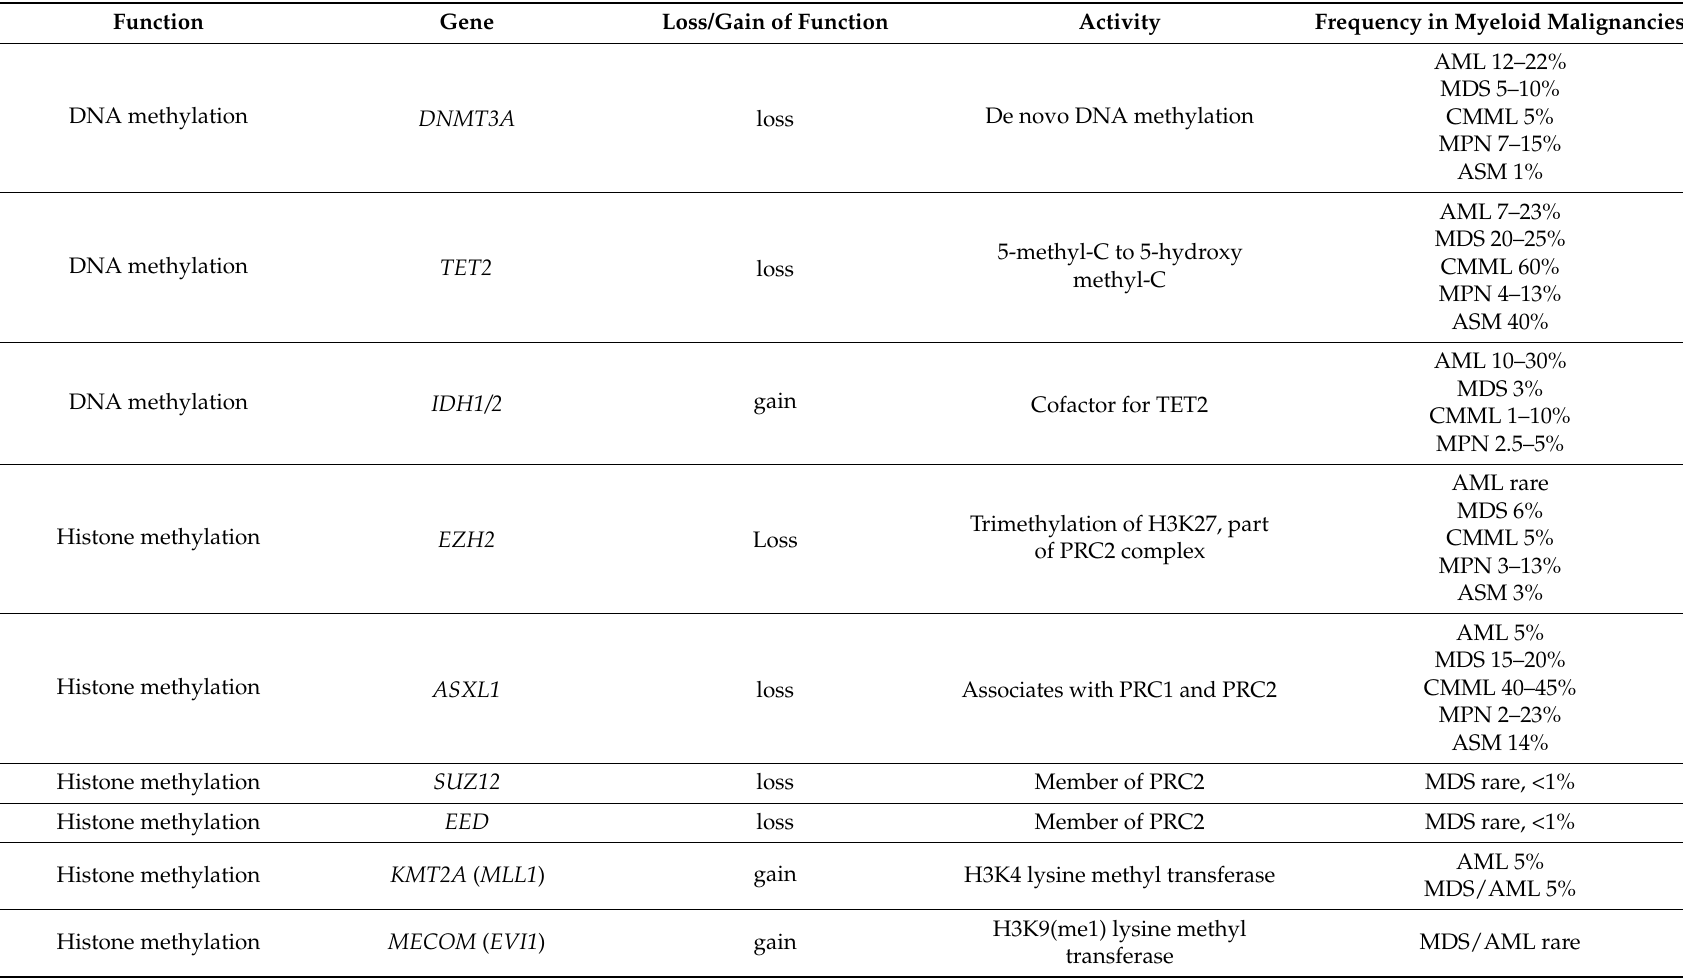
Table 1. In all types of myeloid malignancies, genetic alterations in epigenetic modifiers are found, however the mutation frequency varies between diseases. For references please see